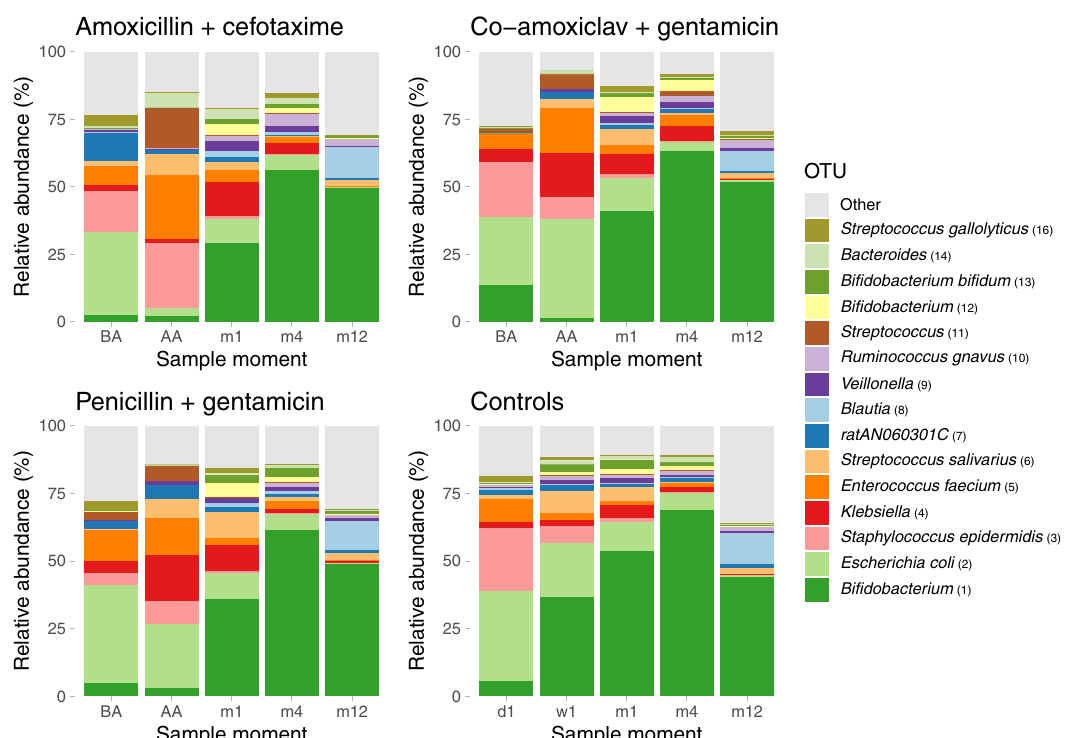
Fig. 3 Mean relative abundance of most abundant OTUs. Mean relative abundances of the 15 most abundant OTUs are depicted for all samples per time point, strati fi ed by antibiotic regimen. BA = before antibiotics, AA = after antibiotics, d = day, w = week, m = month. In some cases, multiple OTUs of individual bacterial species were identi fi ed, so OTUs are referred to by their taxonomical annotations and a rank number (shown in parentheses), which is based on the abundance of each given OTU in the overall dataset. Source data are provided as a Source Data fi